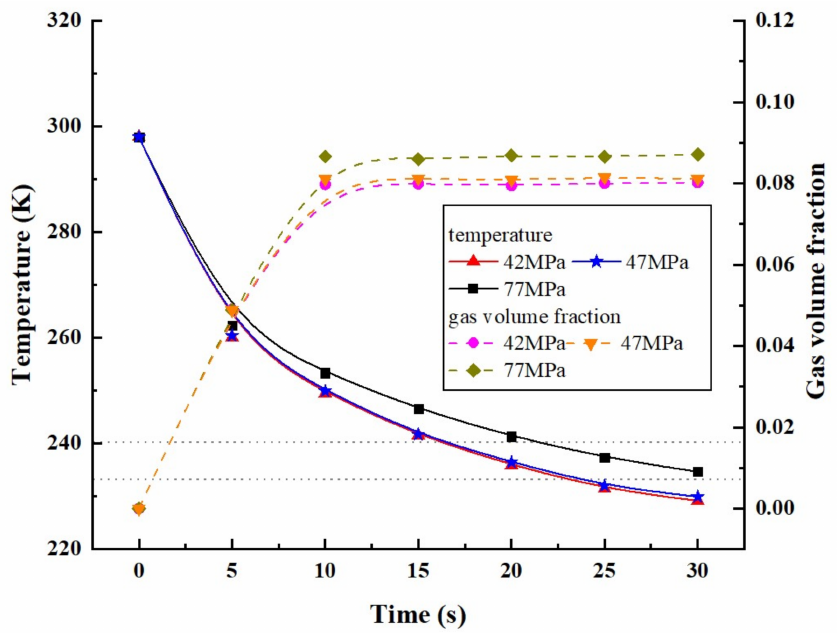
Figure 11. Influence of different hydrogen inlet pressures on precooling temperature and R23 gas volume